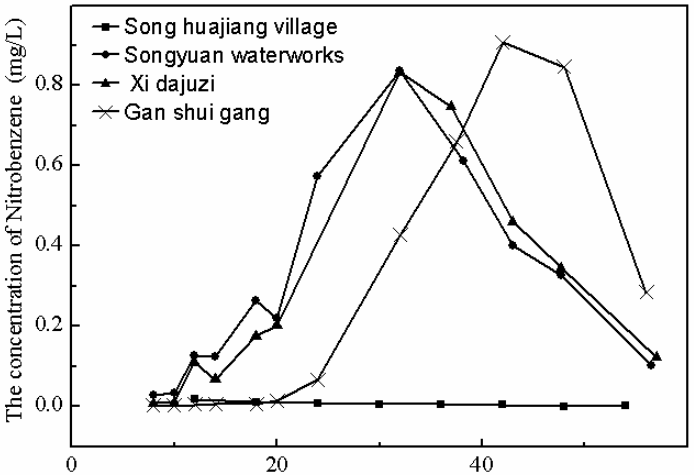
Figure 3. Nitrobenzene concentrations at four emergency monitoring sections during the chemical spill incidents.